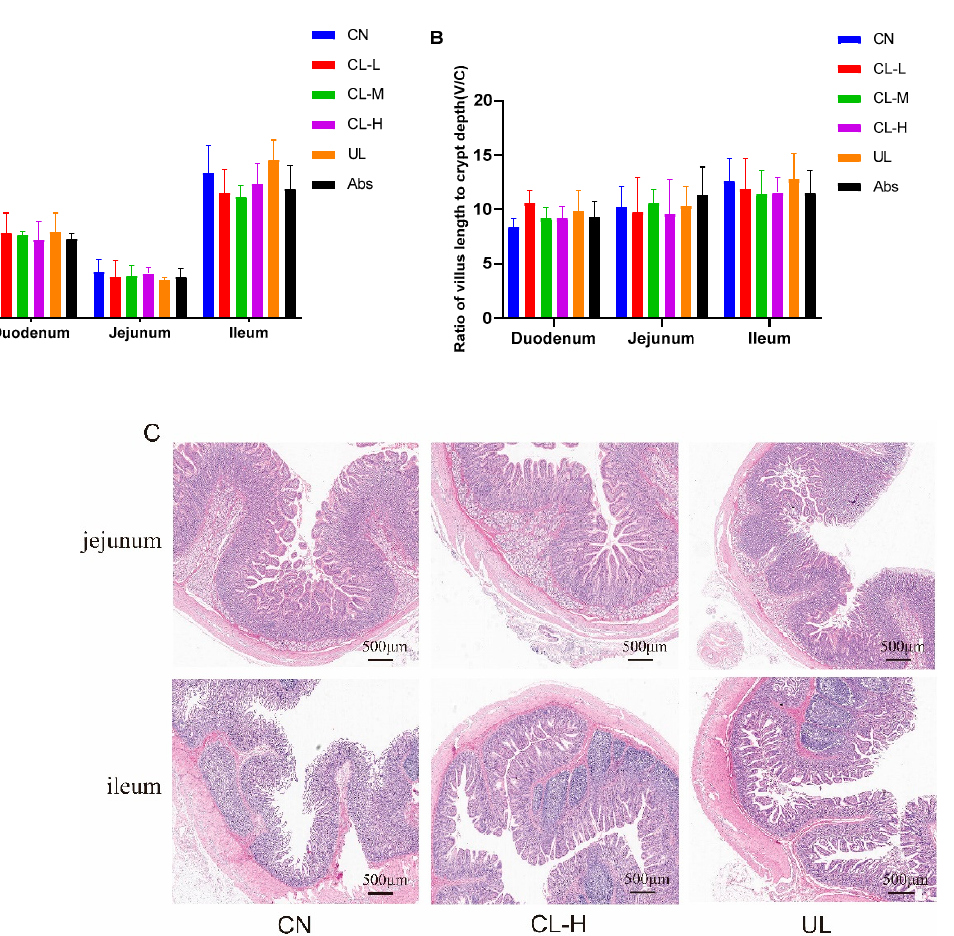
Figure 4. Effects of the CL-L, CL-M, CL-H, UL and Abs dietary interventions on small intestinal mucosal morphology. ( A – C ) intestinal wall thickness, ratio of villus length to crypt depth (V/C) and HE staining microscopy results (40 ×). The data are presented as the means ± SE ( n = 4).